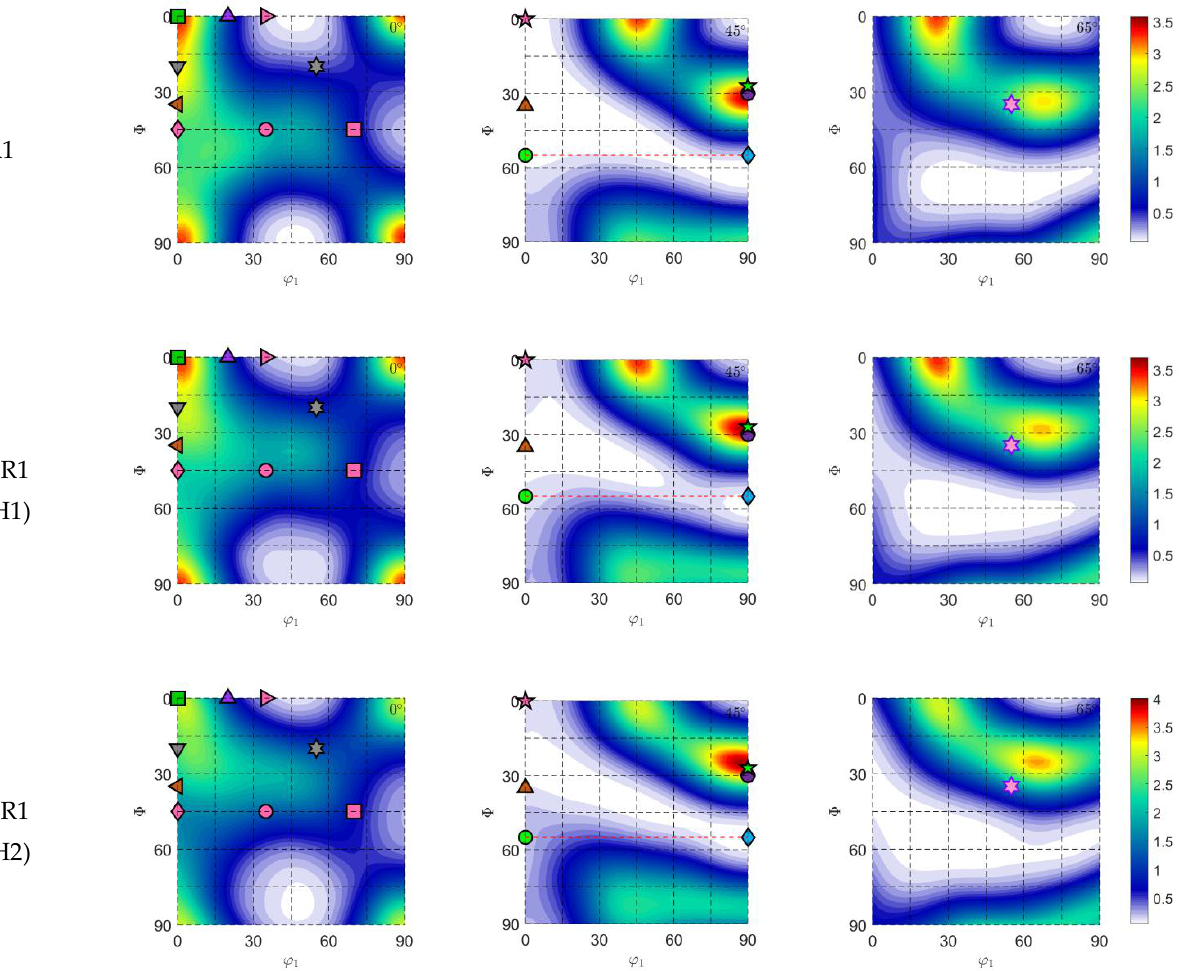
Figure A9. ODF sections for the first pass with a 30% thickness reduction per pass.